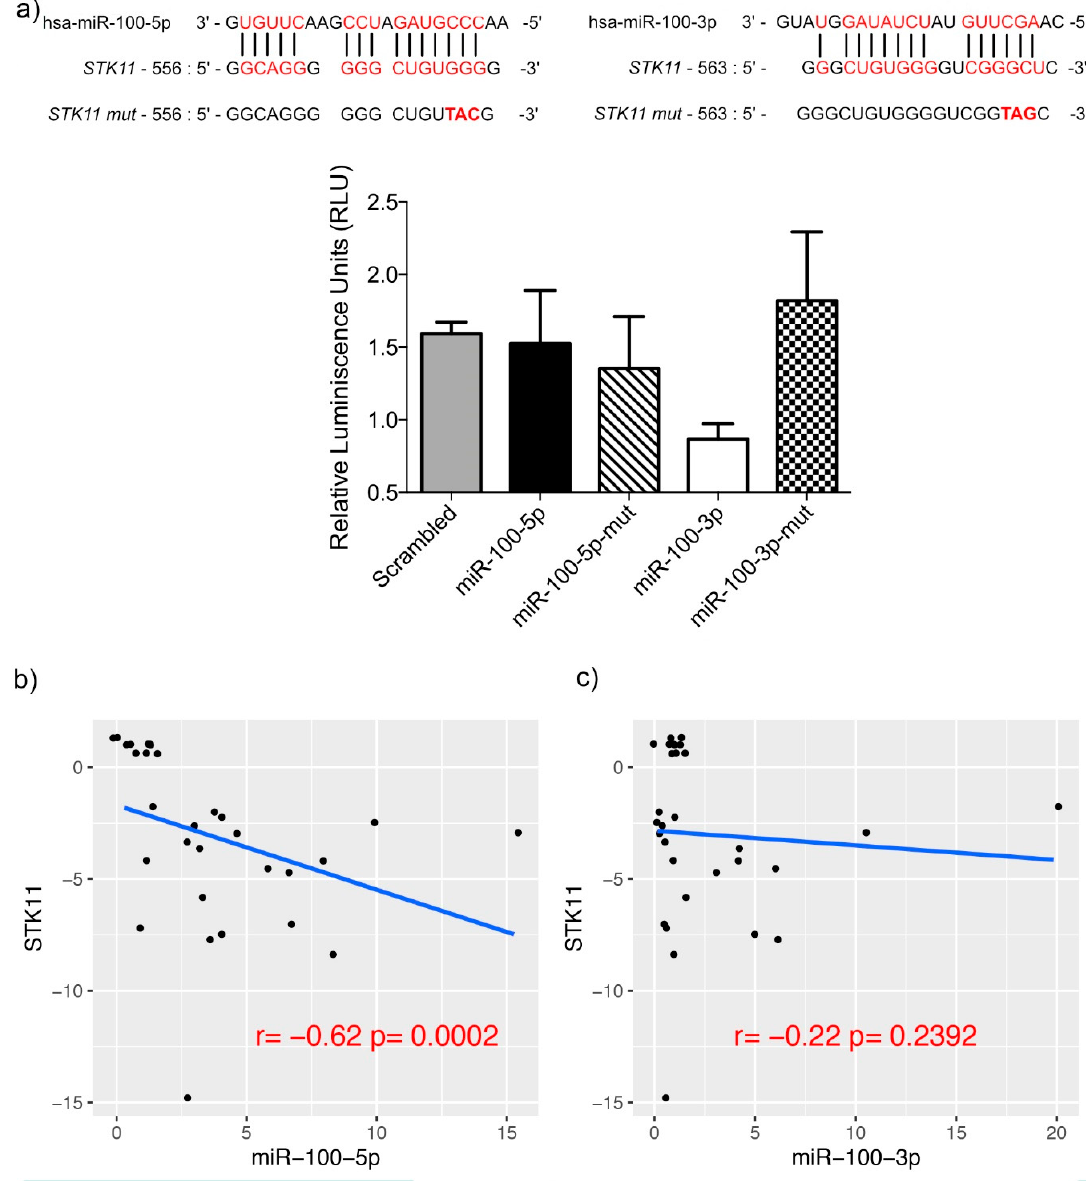
Figure 5. Dual-light Luciferase Assay. ( a ) Luciferase assay and constructions with the interaction of STK11 and its mutated region with miR-100-5p and miR-100-3p. ( b , c ) Correlation between the expression of matched tumor samples of STK11 and miR-100-5p and miR-100-3p, respectively.